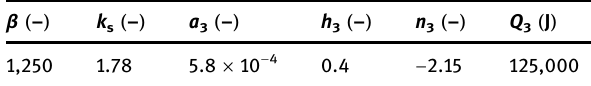
Table 2: Fitted parameters in the Avrami model